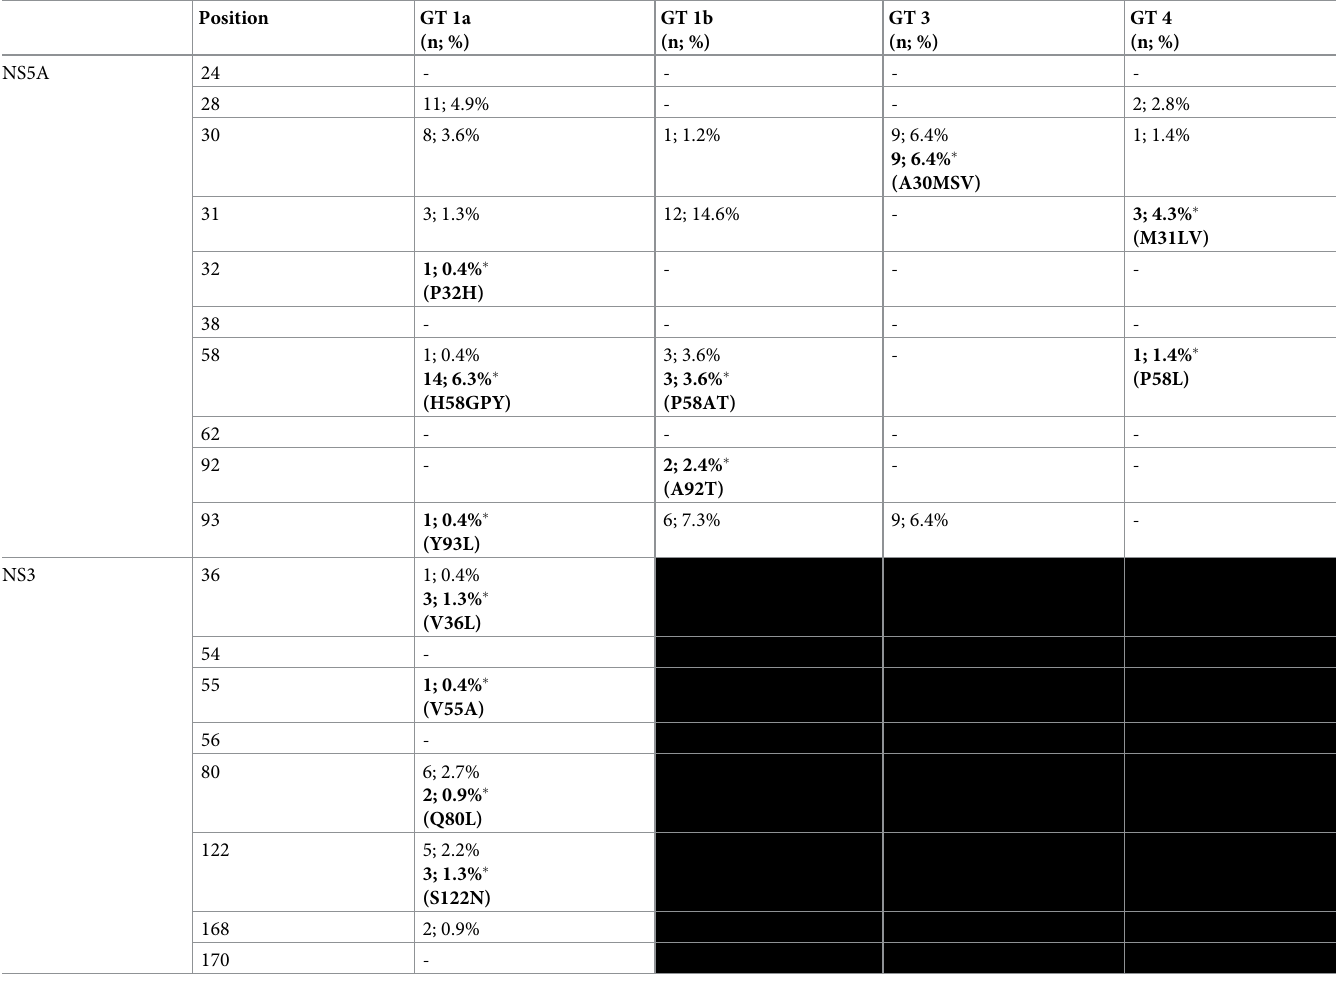
Table 2. Prevalence of the resistance associated substitutions (RASs) in NS5a/NS3 in the population